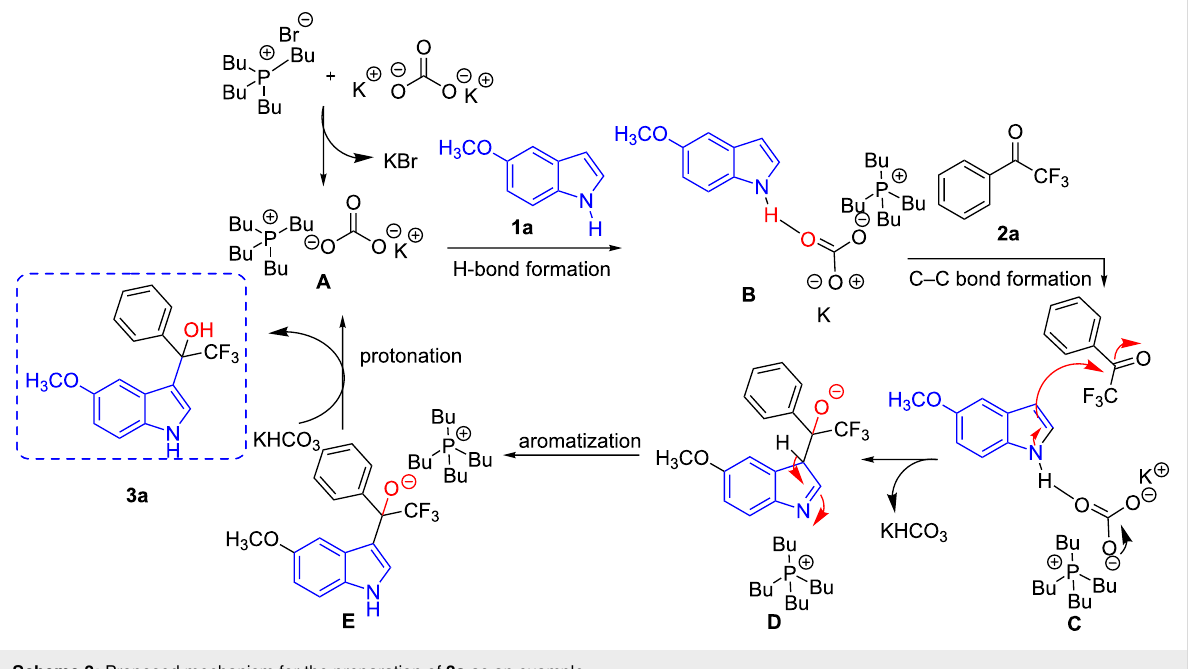
Scheme 3: Proposed mechanism for the preparation of 3a as an